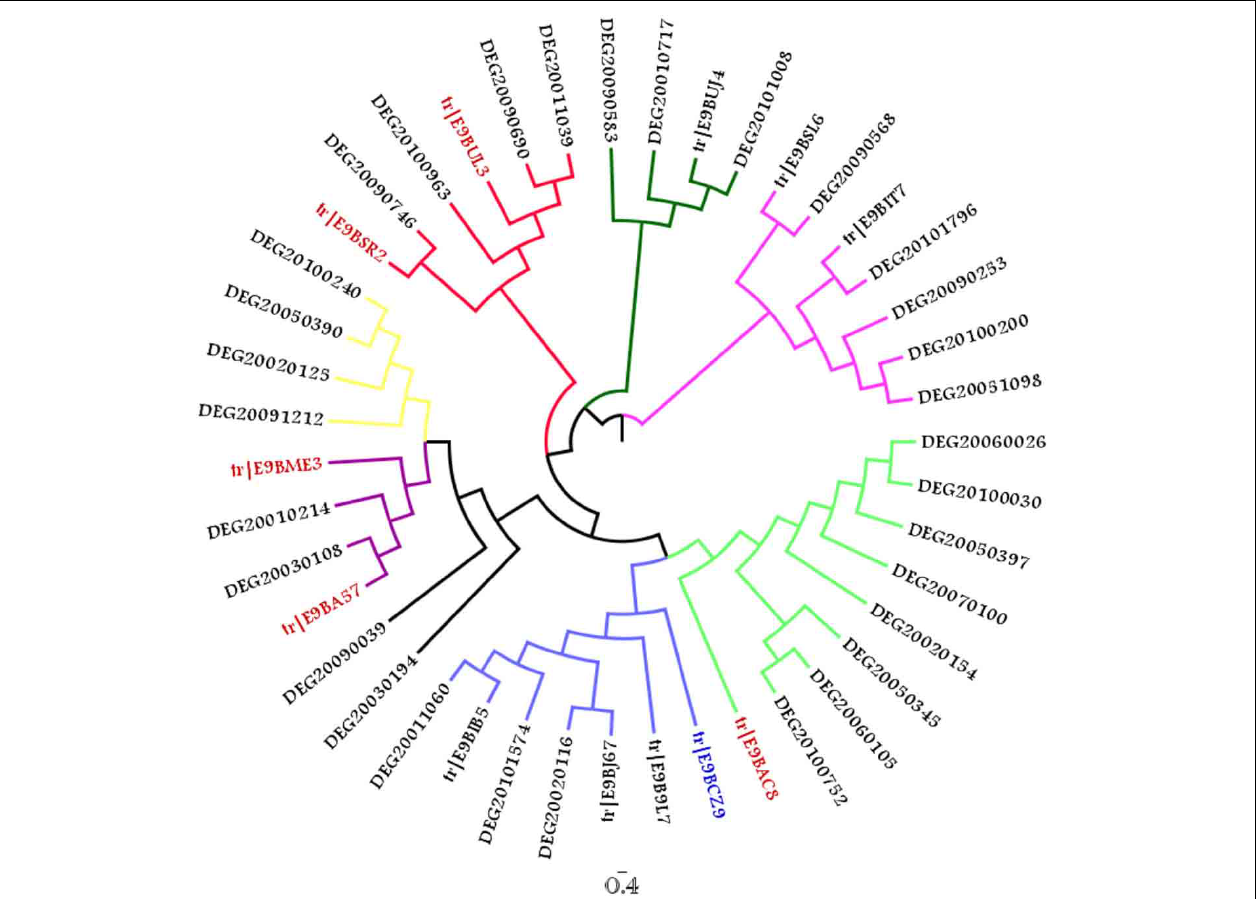
FIGURE 8 | Phylogenetic tree comprising 12 query associated to 32 DEG hits (The taxa colored in Red correspond to sequences belonging to WD40 superfamily while E9BCZ9, colored in blue is closely related to Nep1, a methyltranferase involved in ribosomal